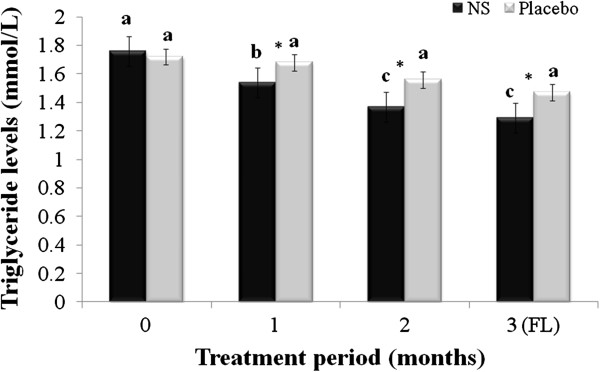
Changes in serum triglyceride (TG); menopausal women randomly assigned toNigella sativa(N.S) or placebo groups were treated for 2 months and blood samples taken at baseline, and 1 and 2 months after the start of the intervention, and one month after cessation of intervention (FL), and used to evaluate serum TG. Results are expressed as mean ± SD. *significant between N. S vs. placebo group at p < 0.05. Different letters on bars representing different intervals for the same group indicate significant difference between the intervals for the same treatment (p < 0.05).